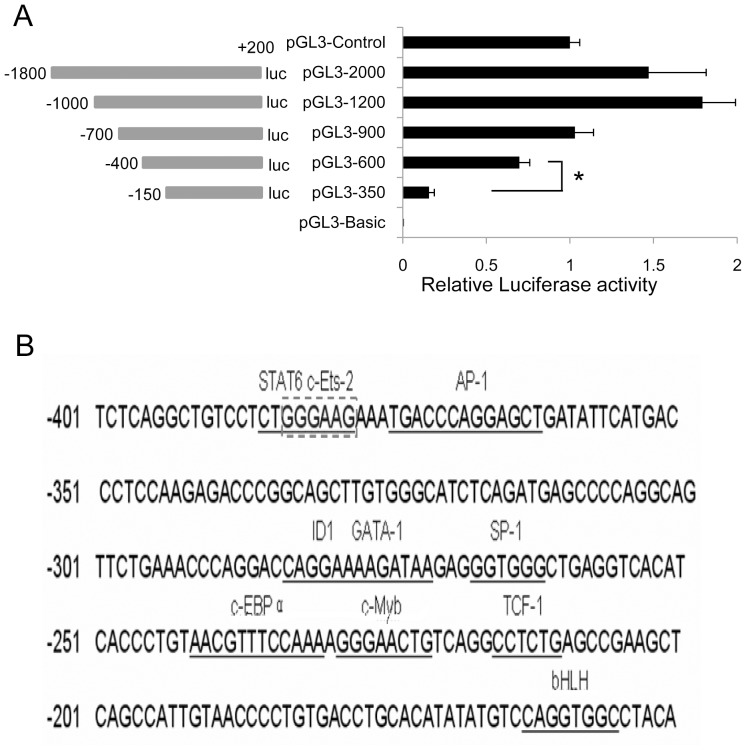
Determining the core promoter region of the UCA1 gene and its putative transcriptional factors by bioinformatical prediction.(A) Luciferase assay. Five truncated DNA fragments of the UCA1 promoter region in pGL3 vectors, a negative control vector, pGL3-basic, and positive control vector, pGL3-control, were transfected into BLZ-211 cells. Luciferase activities were measured at 48 h after transfection. Values represent means ± SD of at least three independent experiments. *P<0.05. (B) Transcriptional factors prediction by using MatInspector software. Transcription factors with high prediction score were present.